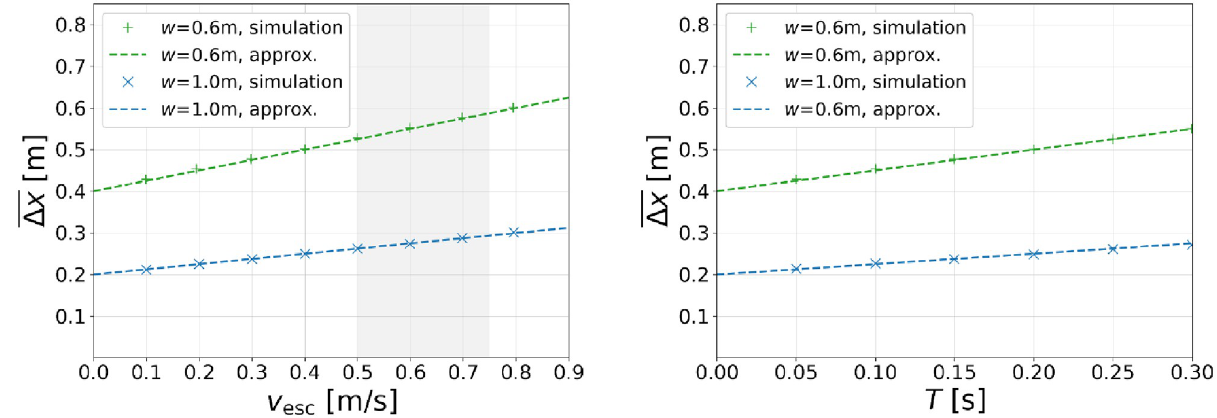
¼ 2 for w = 1.0 m, and O ¼ 1 for w = 0.6 m. The 0 0